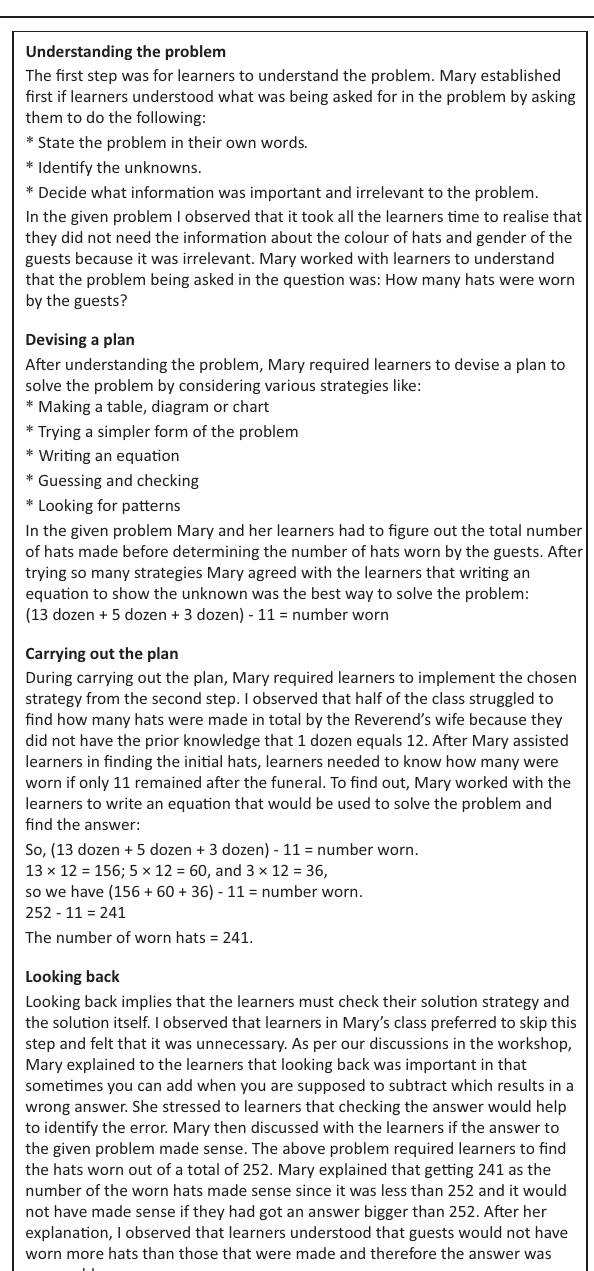
FIGURE 3: Implementation of the mathematical problem-solving pedagogy by teacher